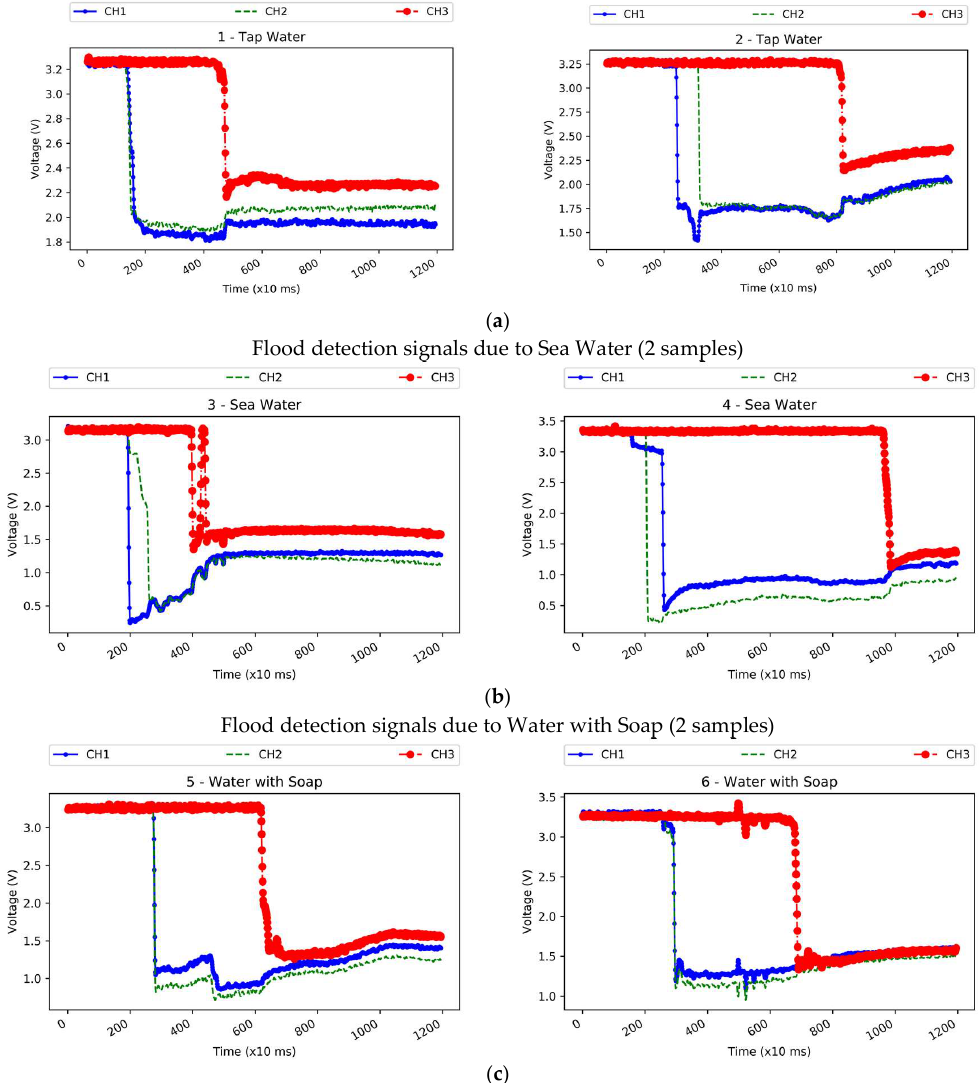
Figure 11. Flood detection signals. ( a ) Tap water; ( b ) Sea water; ( c ) Water with